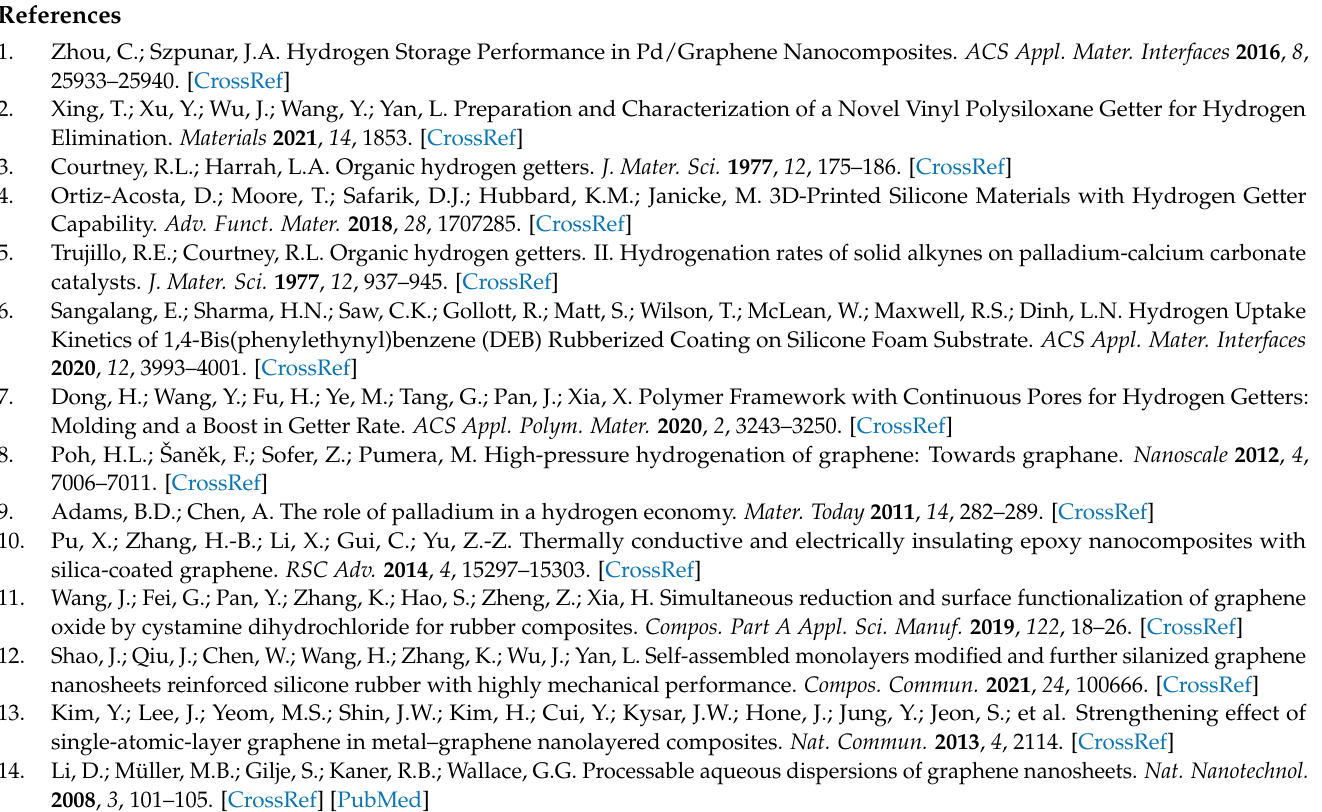
Figure S4. Schematic illustration of pure hydrogen test apparatus, Figure S5. The size of 200 Pd nanoparticles was randomly